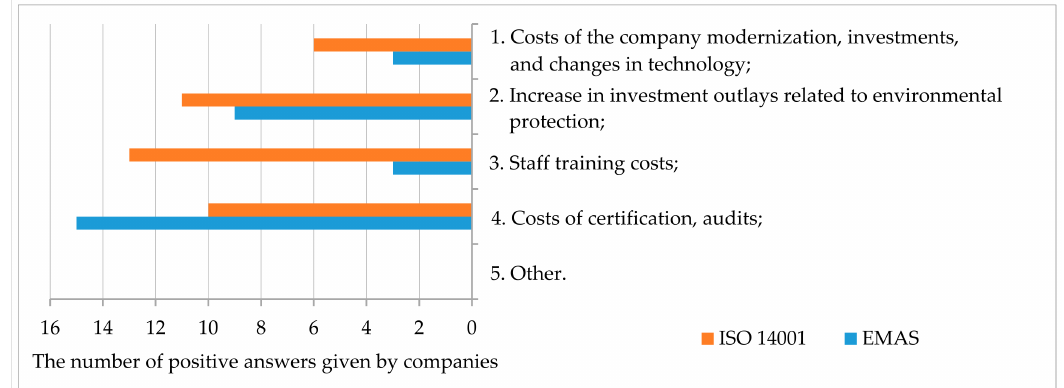
Figure 5. Answers to the fifth question of the survey: Costs of EMAS/ISO14001 implementation in a